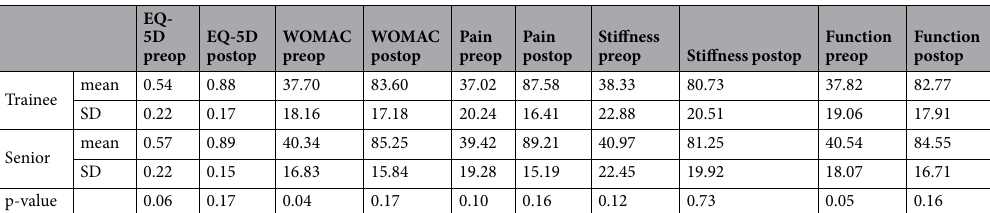
Table 3. Western Ontario and McMaster Universities Arthritis Index (WOMAC) and Euro-Qol 5D-5L (EQ- 5D) by surgeon grade preoperative and 1 year after minimally invasive THA * . * For quantitative data values are given as mean (SD = standard deviation), preop = preoperative, postop = postoperative.